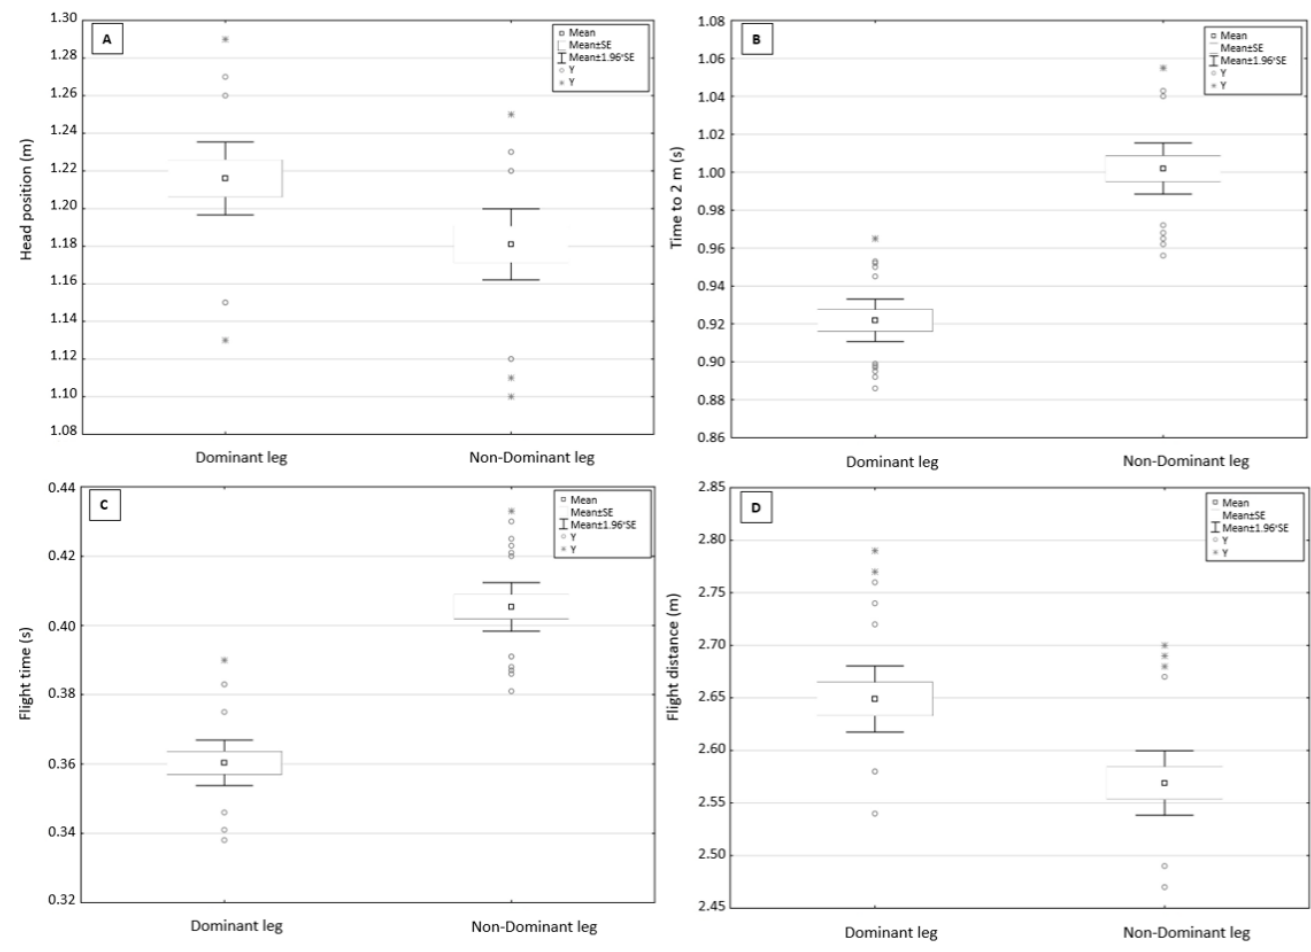
Figure 2. Dominant and non-dominant leg placed on the front edge— A —head position; B —time to 2 m; C —flight time; D —flight distance.